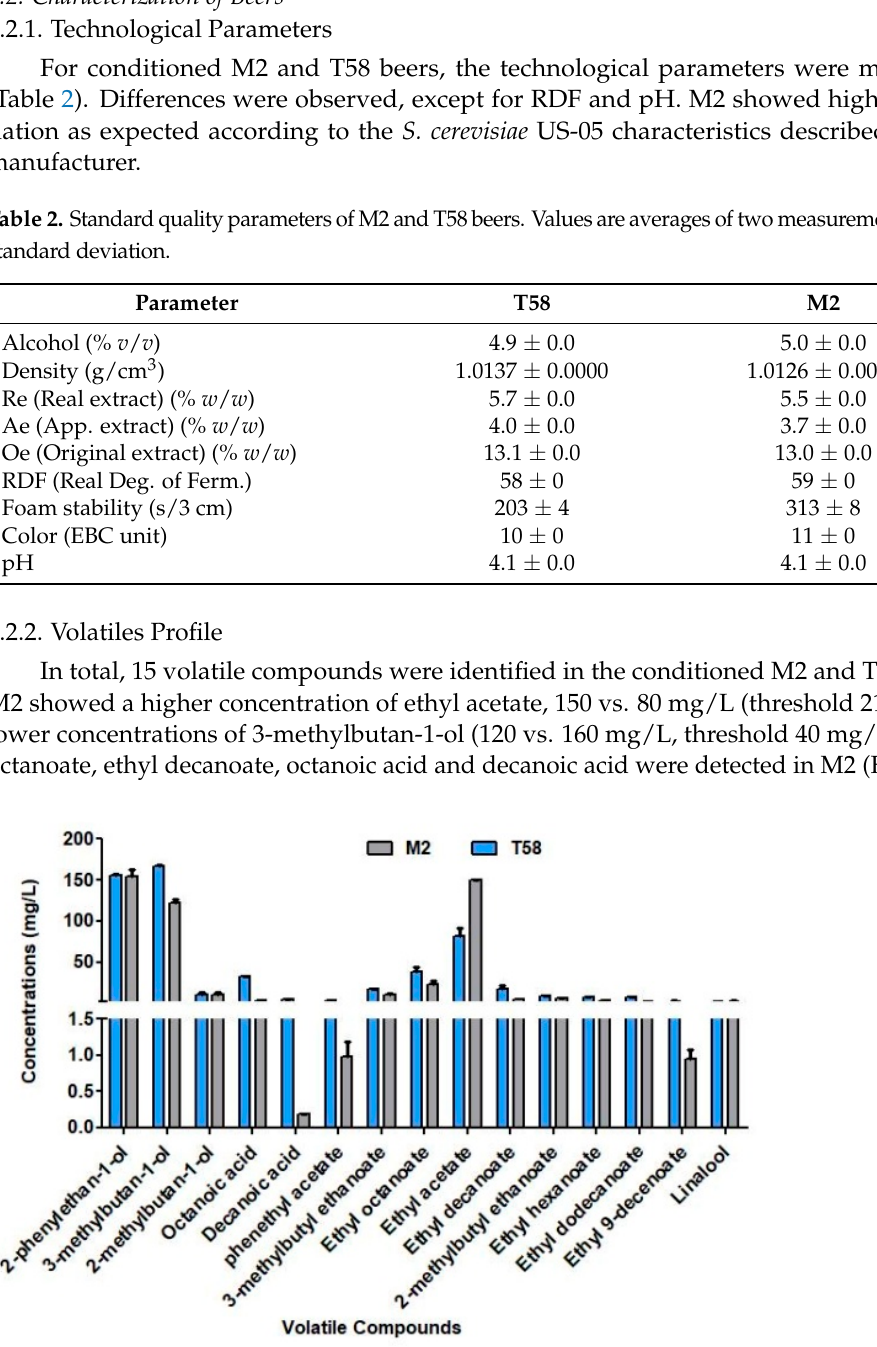
Table 2. Standard quality parameters of M2 and T58 beers. Values are averages of two measurements ± the standard deviation.